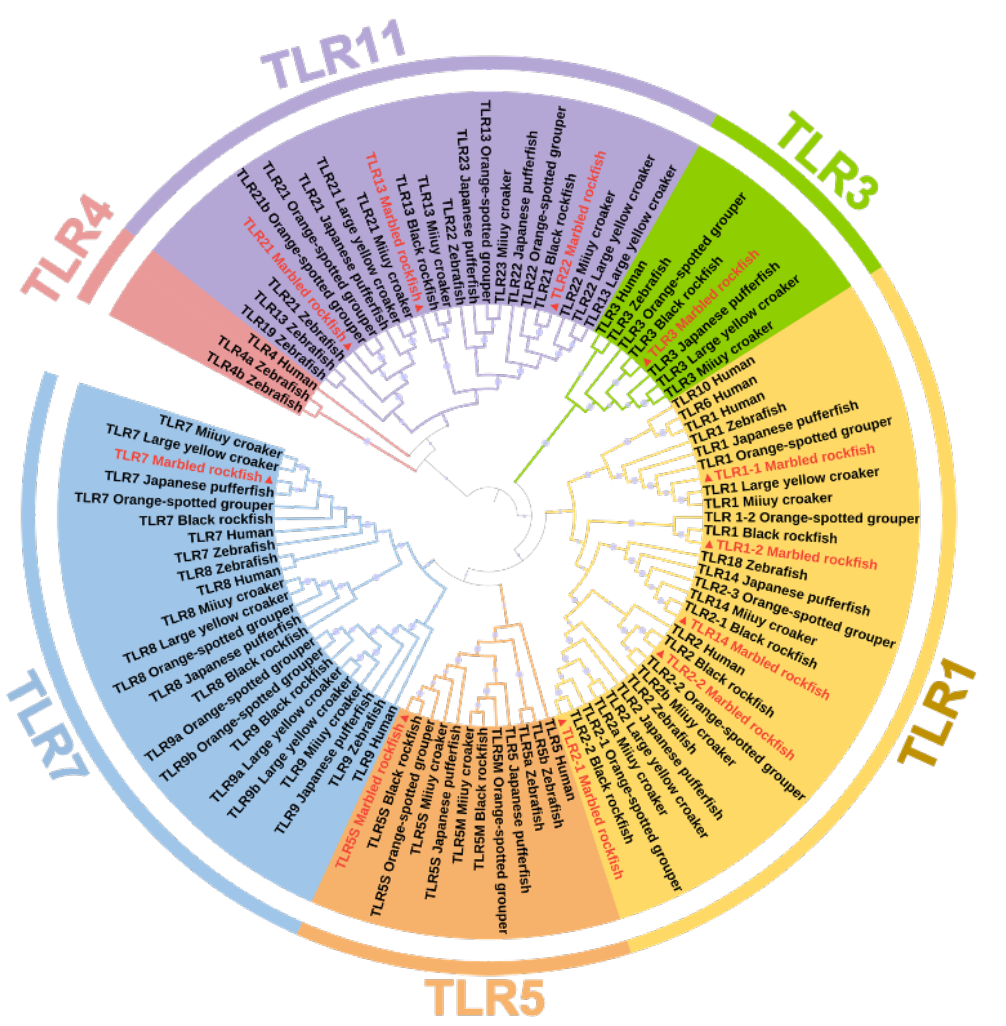
Figure 3. Phylogenetic tree of TLR gene families of selected species. TLRs from marbled rockfish are marked with triangle symbols and red font. The percentage of replicate trees in which the associated taxa clustered together in the bootstrap test (1000 replicates) is shown by spot symbols of different sizes on the branches.